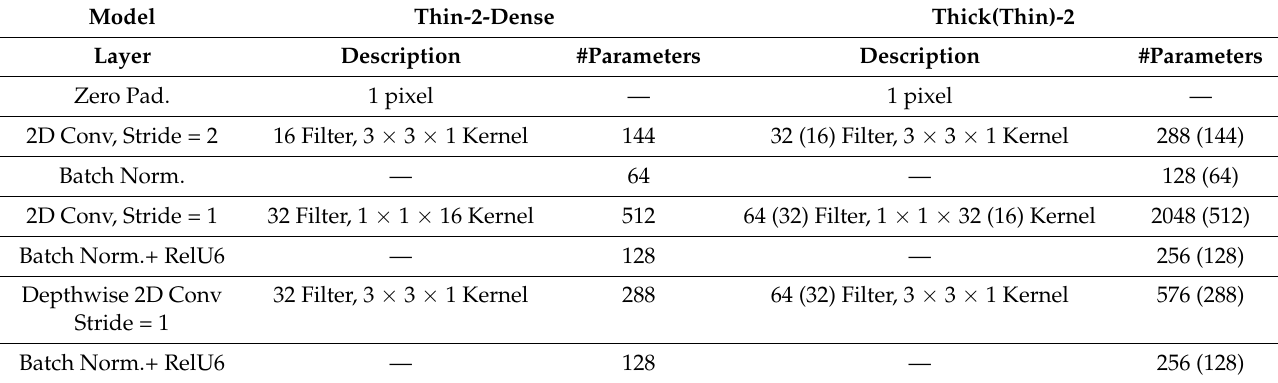
Table A2. Parameters of the Image Classification Unit: models Thin-2-Dense and